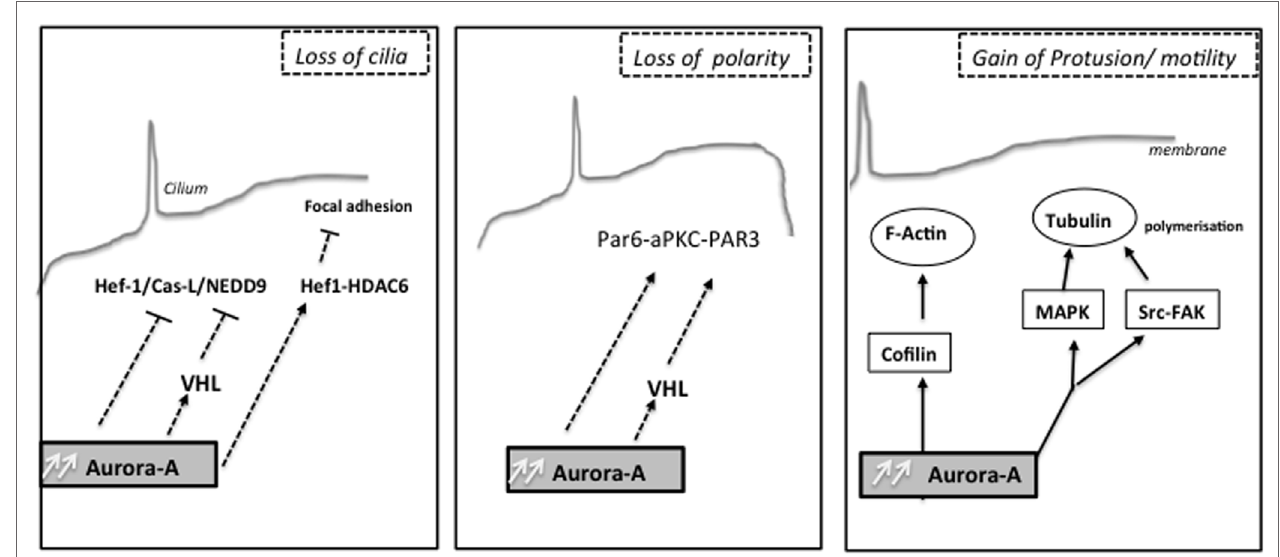
FiGURe 2 | Non-mitotic functions of the kinase Aurora-A: different biological processes as cilia resorption, cell polarity or cell migration are influenced by Aurora-A upstream mitosis, which can later affect chromosome segregation